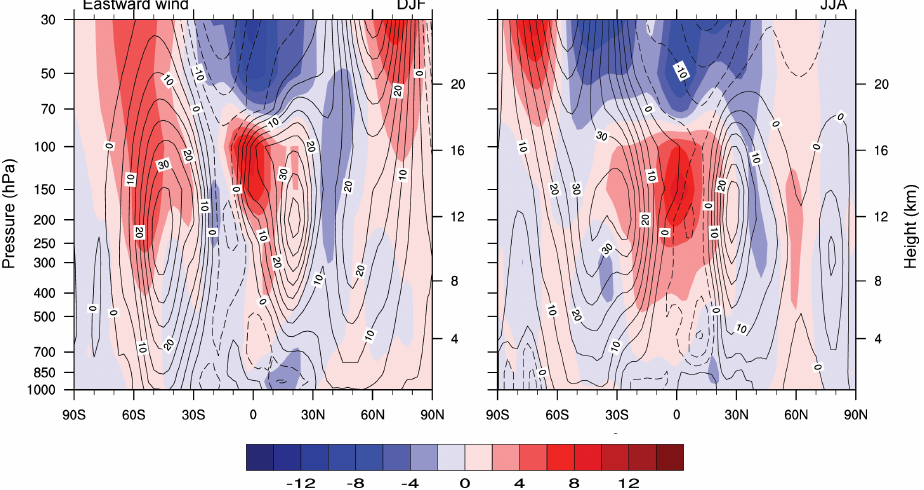
Fig. 10. Zonally averaged zonal wind (ms − 1 ) climatology from NorESM for 1976–2005 (black contours) and differences from the NCEP (1976–2005) climatology (Kalnay et al., 1996) (colour). Left and right panel is for boreal winter (DJF) and summer season (JJA),